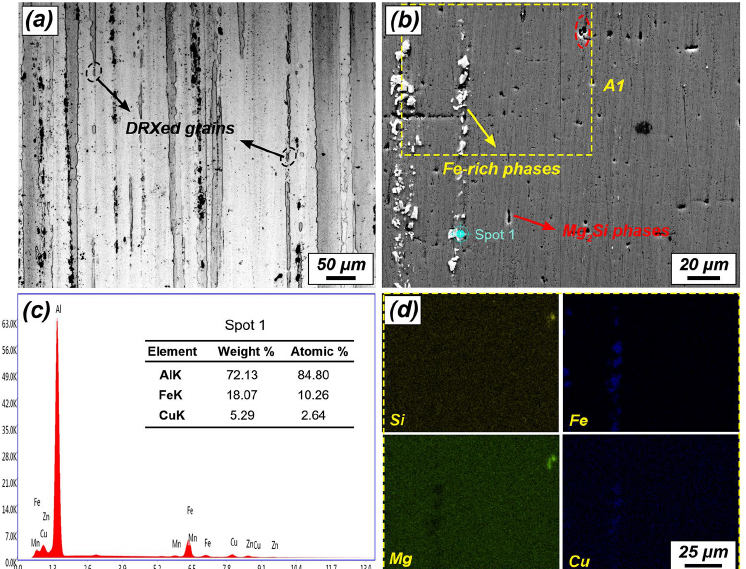
Figure 5. ( a ) Optical microscopy (OM) image, ( b ) backscattered scanning electron microscopy (SEM) image, and ( c , d ) corresponding energy-dispersive X-ray (EDX) results for the as-extruded T4-7075 Al alloy.